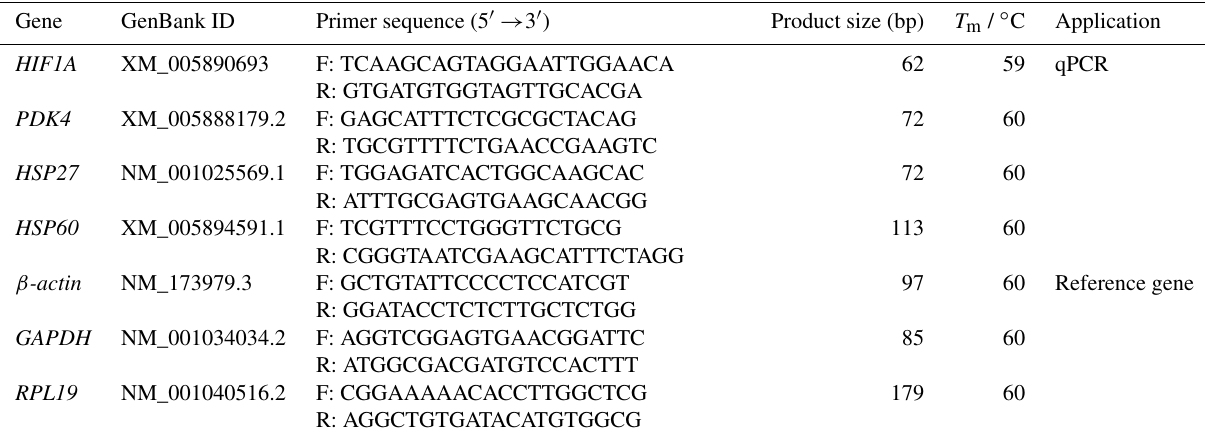
Table 1. Primers used in the present study. Gene GenBank ID Primer sequence (5 (cid:48) → 3 (cid:48) ) Product size (bp) T m / ◦